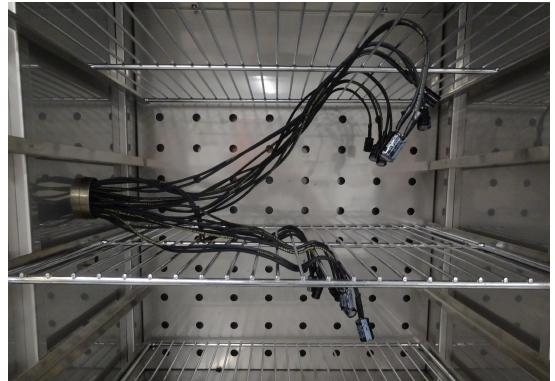
Figure 9. ECs under test located in laboratory oven with cables for connection back to